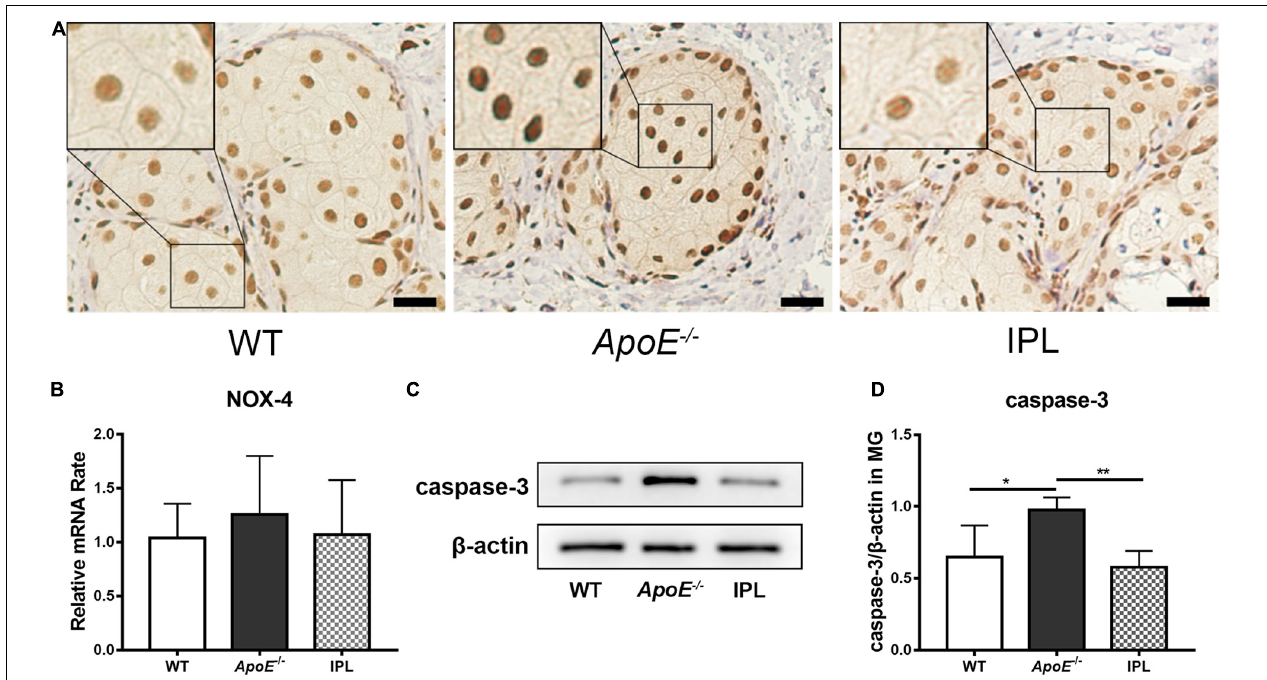
FIGURE 6 | Downregulation of oxidative stress and apoptosis after IPL treatment. (A) immunohistochemical staining of NOX-4. The black frame indicates relatively decreased nuclear staining of the oxidative stress marker NOX-4 in IPL-treated mice compared with APOE − / − mice. (B) NOX-4 gene expression ( n = 5–6/group).